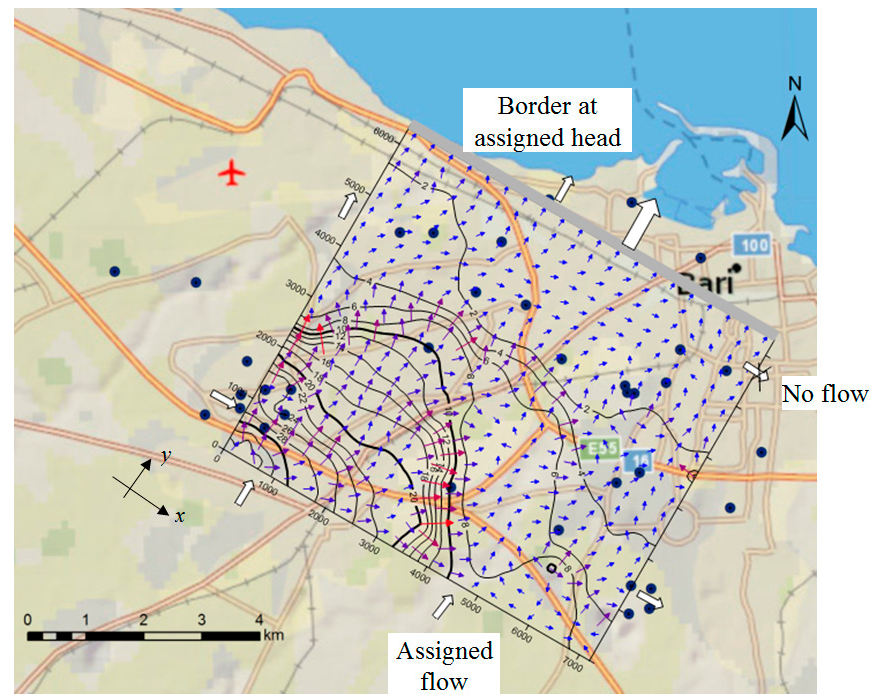
Figure 5. Model output: Freshwater heads (contour lines) in meters above sea level and water velocities (vectors) ranging from 10 (in blue) to 80 m/d (in red) in the studied area. White arrows and the gray border indicate the boundary conditions imposed during flow simulations; solid circles are wells.